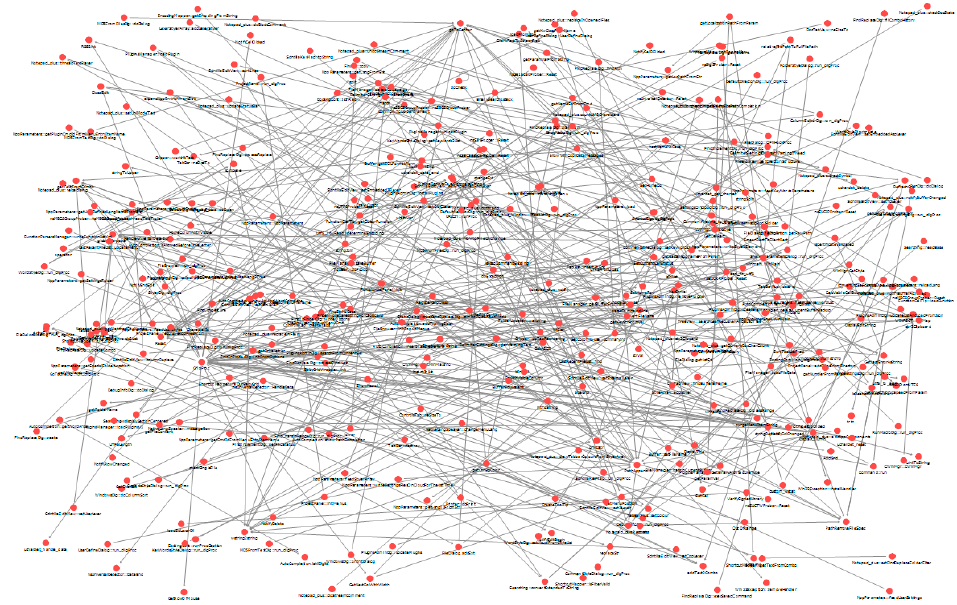
Figure 3. C++ source function network of Notepad++.